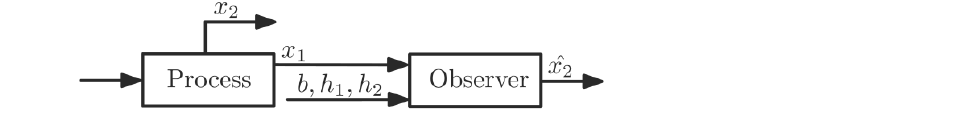
Figure 1. General structure of the observer. x 1 is the known state, x 2 is the unknown state, b , h 1 , h 2 are known terms of plant model (1), (2), and ˆ x 2 is the estimate of x 2